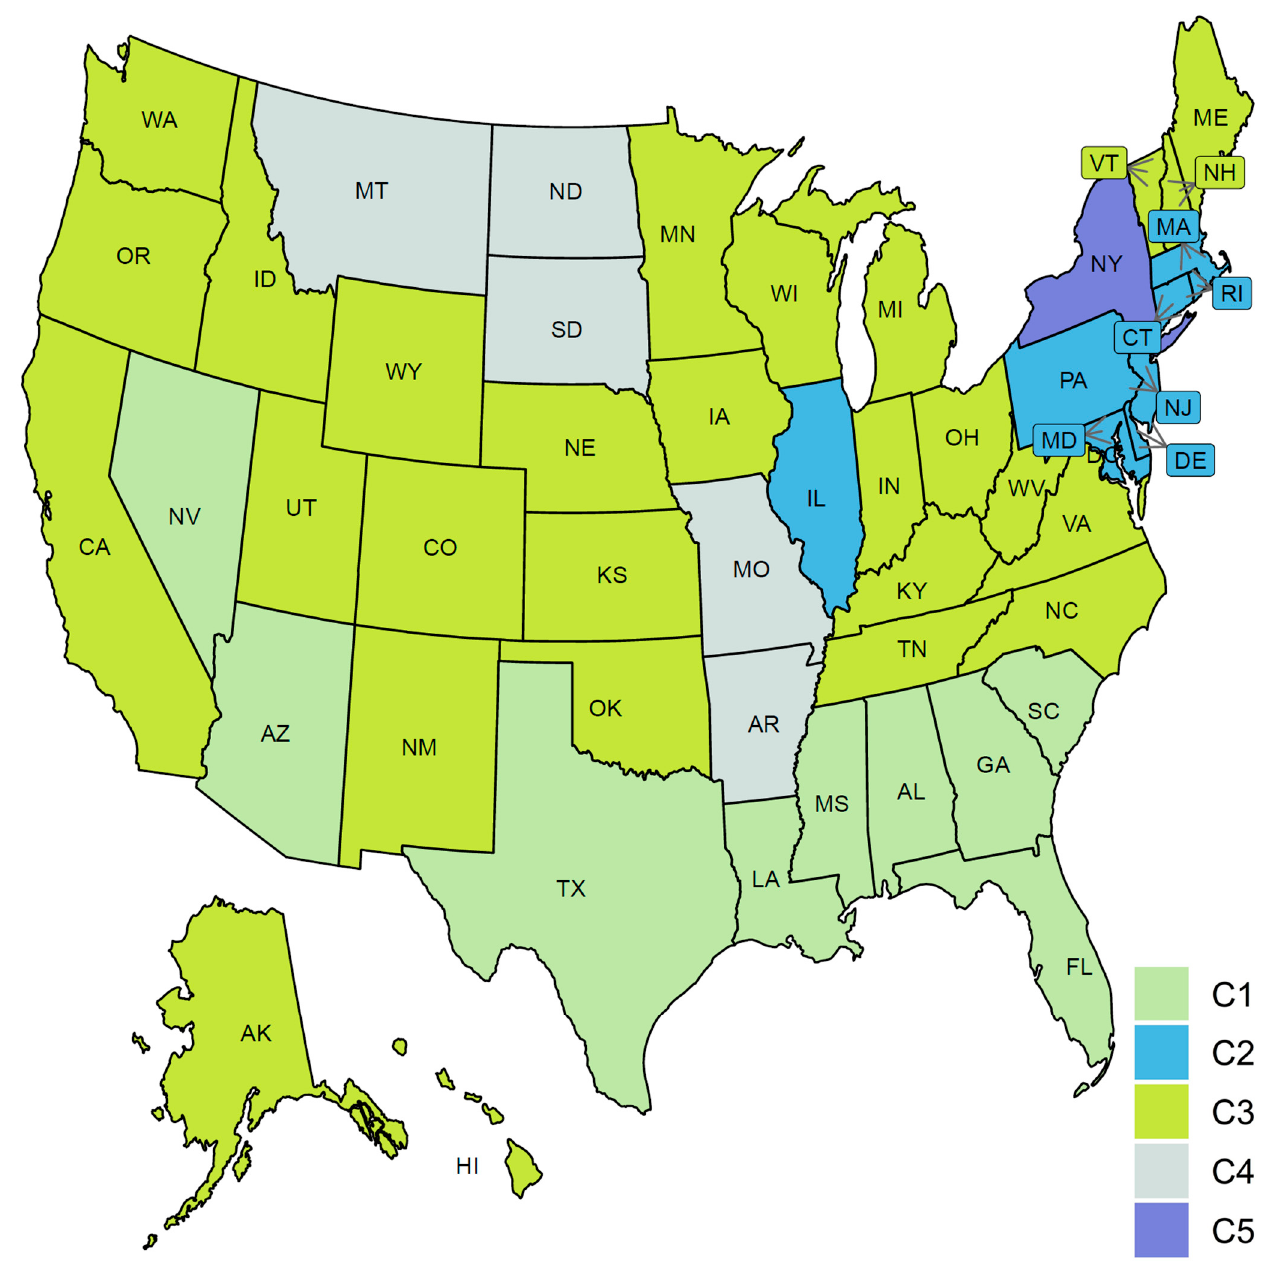
Figure 11. Clustering result of the 51 states based on the COVID-19 death trajectories. States assigned to the same cluster share the same color.